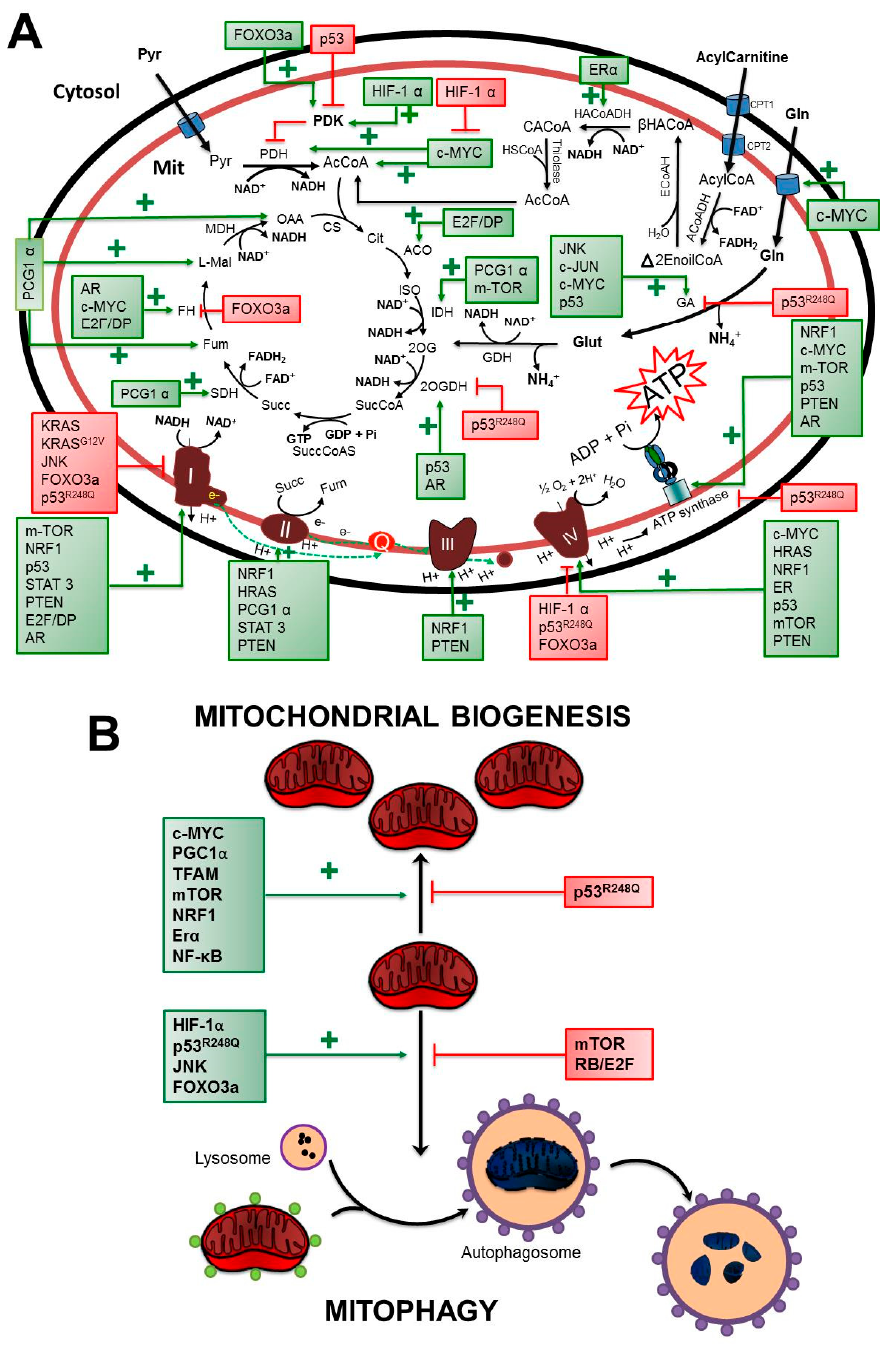
Figure 2. Transcription regulators that modulate ( A ) OxPhos and ( B ) mitochondrial biogenesis / mitophagy in cancer cells. Color codes are as in Figure 1. Abbreviations: 2-OG, 2-oxoglutarate; 2OGDH, 2 oxoglutarate dehydrogenase; ACO, aconitase; Cit, citrate; CS, citrate synthase; cyt c, cytochrome c; FH, fumarate hydratase; Fum, fumarate; GA, glutaminase; GDH, glutamate dehydrogenase; Gln, glutamine; Glut, glutamate; HACoADH, β -hydroxyacyl-CoA dehydrogenase; IDH, isocitrate dehydrogenase; Iso, isocitrate; Mal, malate; MDH, malate dehydrogenase; Mit, mitochondria; OAA, oxaloacetate; PDH, pyruvate dehydrogenase complex; Pyr, pyruvate; Q, quinone; SCoAS, succinyl CoA synthase; SDH, succinate dehydrogenase; Succ, succinate.